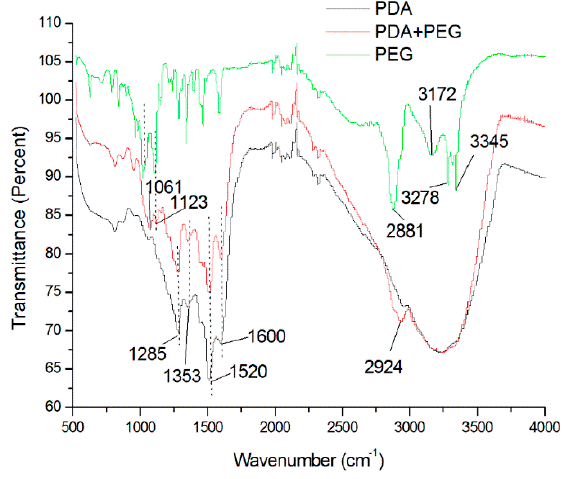
Figure 3. FTIR spectra of PDA + PEG, PDA, PEG treatments on a silicon disk. PDA: polydopamine, PEG: polyethylene glycol.